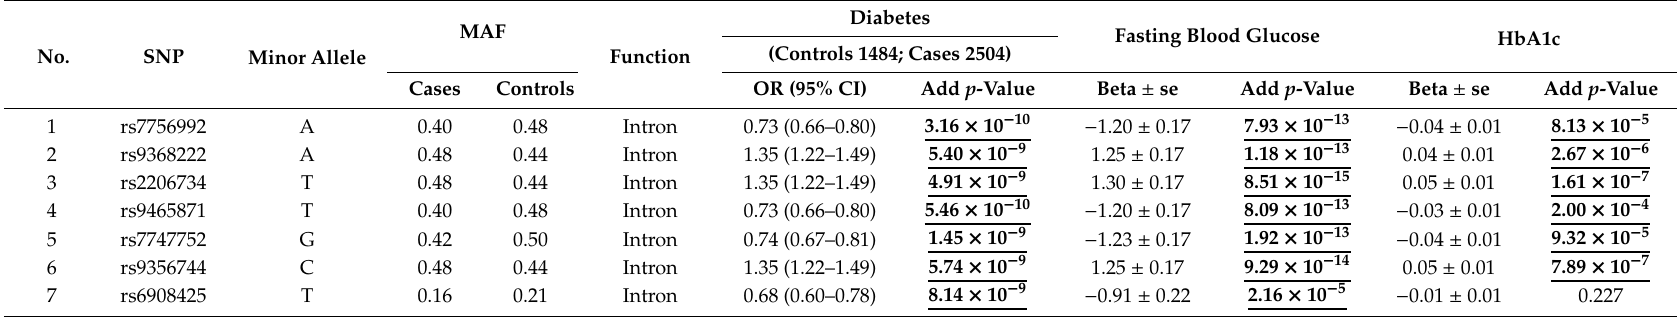
Table 2. The significant association results of SNPs in the CDKAL1 gene with diabetes, fasting blood glucose, and HbA1c in Korean